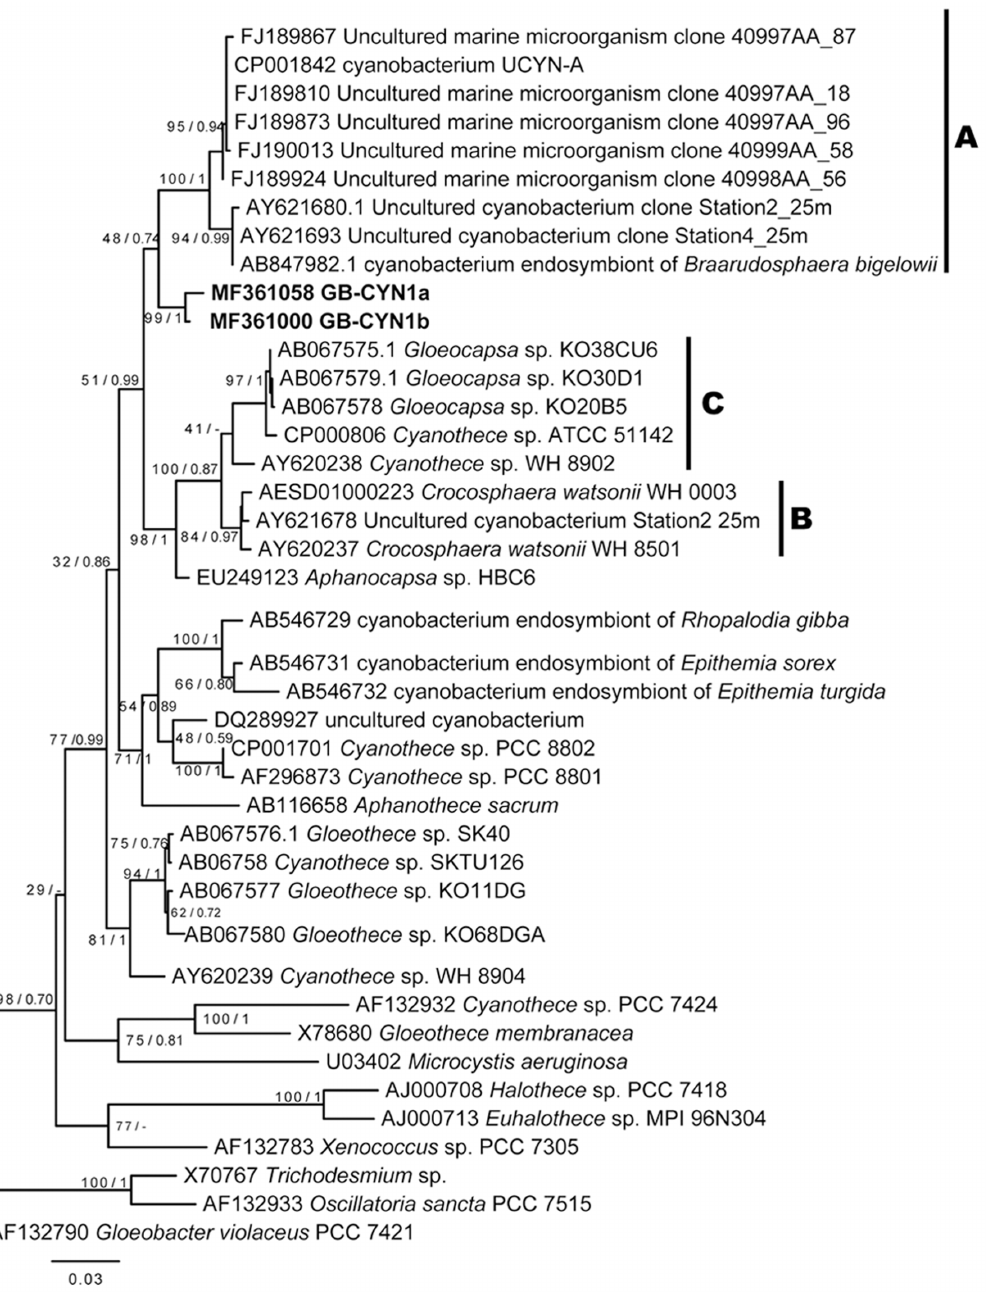
Frontiers in Microbiology |